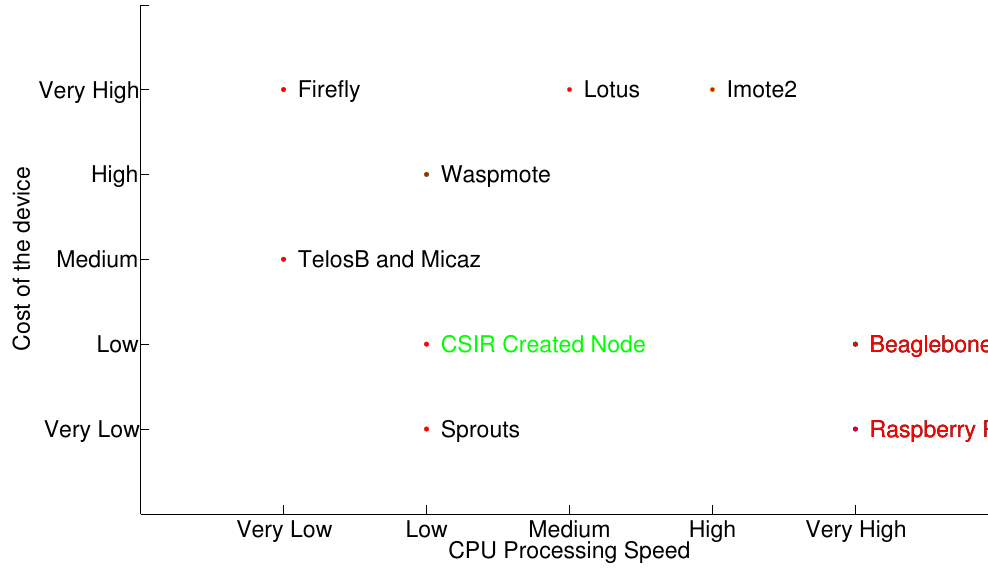
Figure 6. Comparison of processing speed against cost for WSN nodes (commercial off-the-shelf (COTS) and open platforms indicated in green and red,